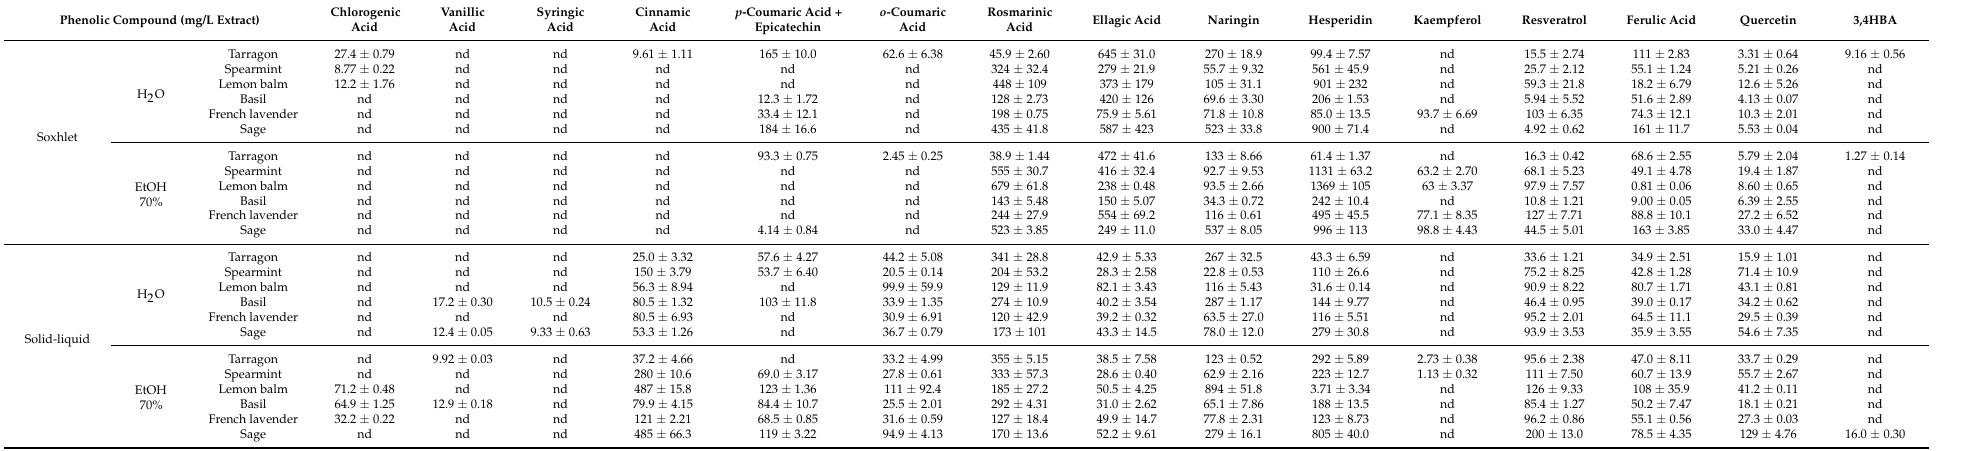
Table 2. Identification and quantification of phenolic compounds present in the extracts